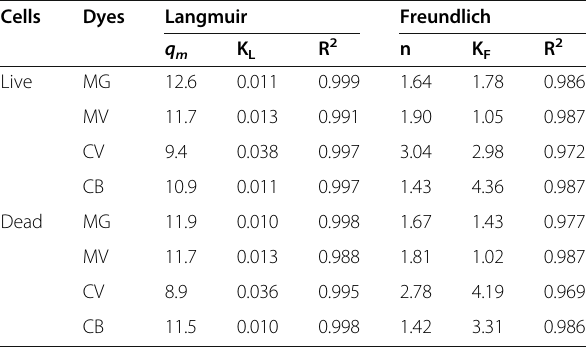
Table 1 Adsorption isotherm models for the sorption of TPM dyes by live and dead cells of Streptomyces sp.